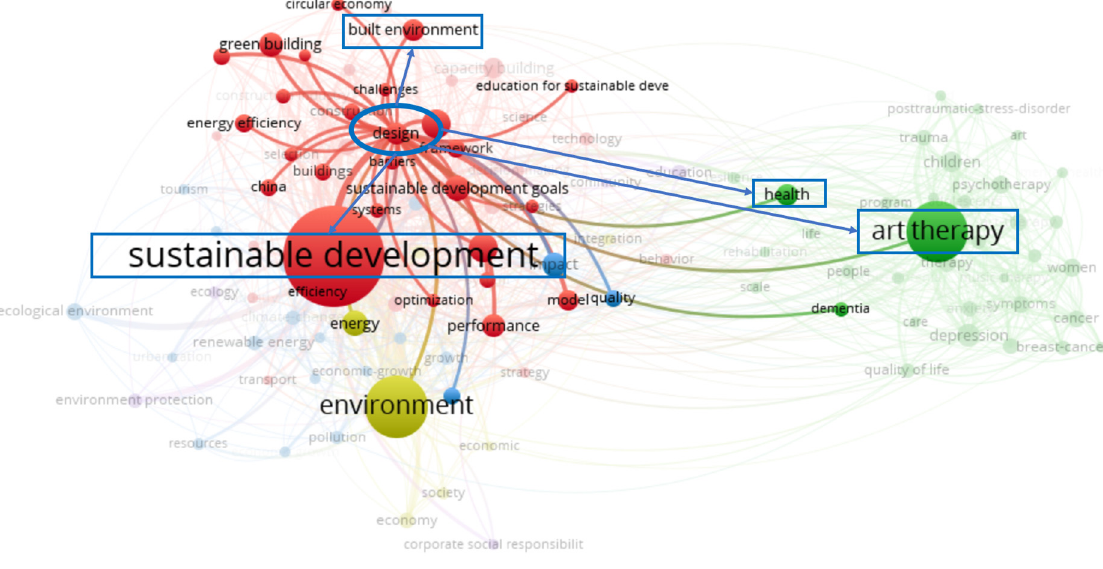
Figure 4. Network visualization map with the theme of design in the WoS core collection database via VOSviewer (devised by the authors).